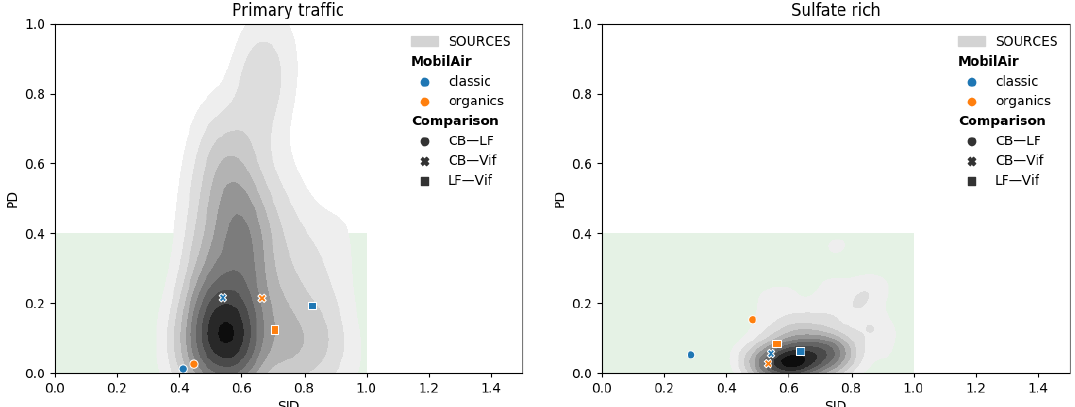
Figure 13. Similarity plots for the factors “primary traffic” and “sulfate-rich” for the pairs of sites formed in this study (Mobil’Air) compared to the probability density function of similarities obtained for the 15 French sites of the SOURCES